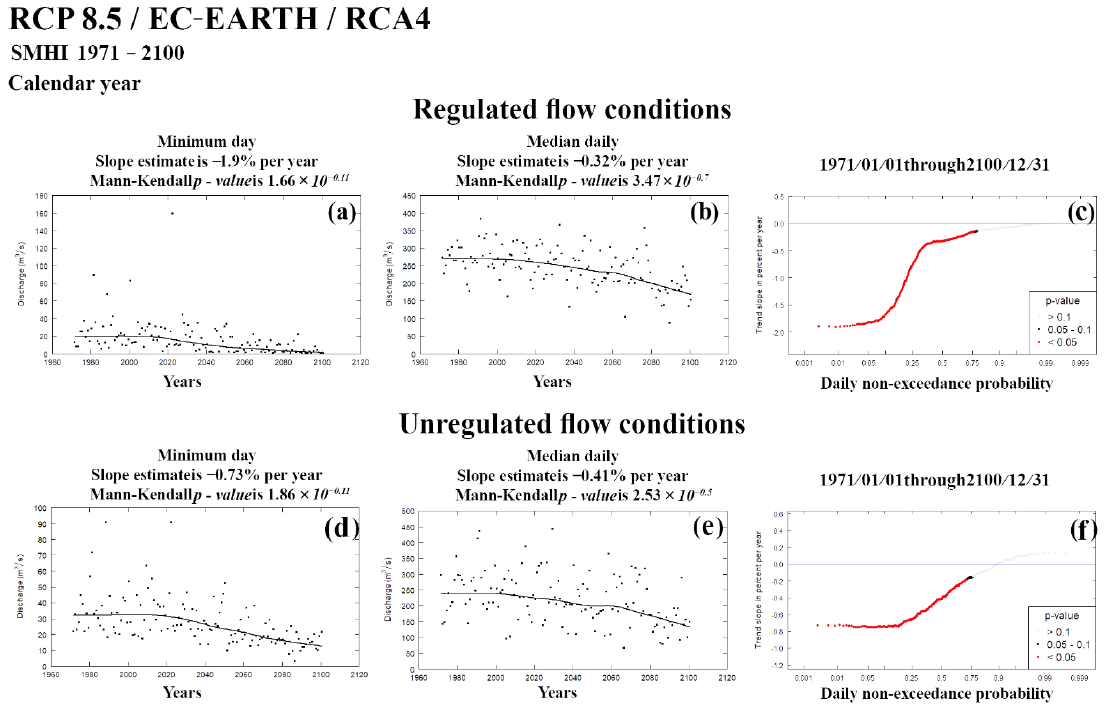
Figure 8. FlowTrend plots from the combination RCP8.5/EC−EARTH/RCA4 for annual simulated daily streamflow for regulated conditions: ( a ) minimum day; ( b ) median day; ( c ) Quantile−Kendall plot, and for unregulated conditions: ( d ) minimum day; ( e ) median day; ( f ) Quantile−Kendall plot.